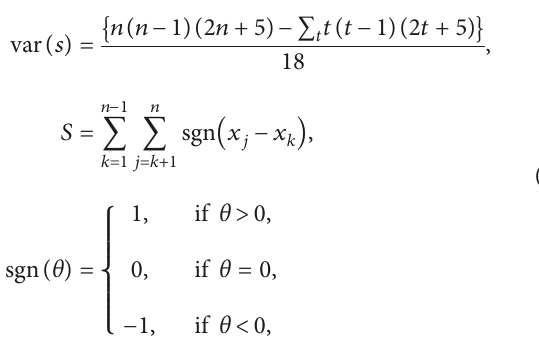
Figure 1: Locations of meteorological stations and selected GCM grid points (solid circles) in the study Table 1: Statistics of climate variables and their weights.